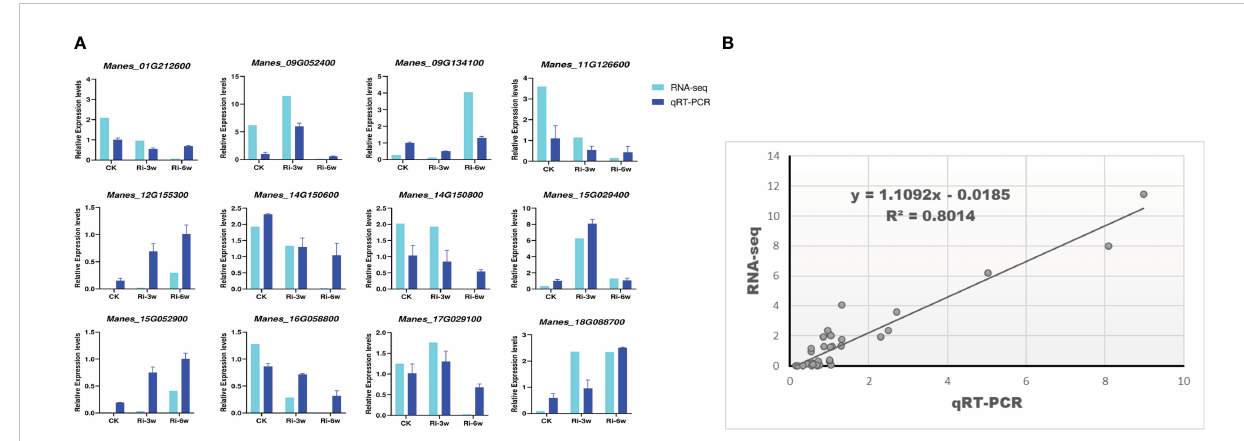
FIGURE 8 qRT-PCR validation of the RNA-seq data. Twelve DEGs were randomly selected for the qRT-PCR analysis. (A) Expression patterns of selected genes by RNA-seq and qRT-PCR. (B) Linear regression analysis of RNA-seq and qRT-PCR data. Relative expression indicates FPKM values for RNA-seq and the quanti fi ed expression levels by the 2¯ DD CT method for